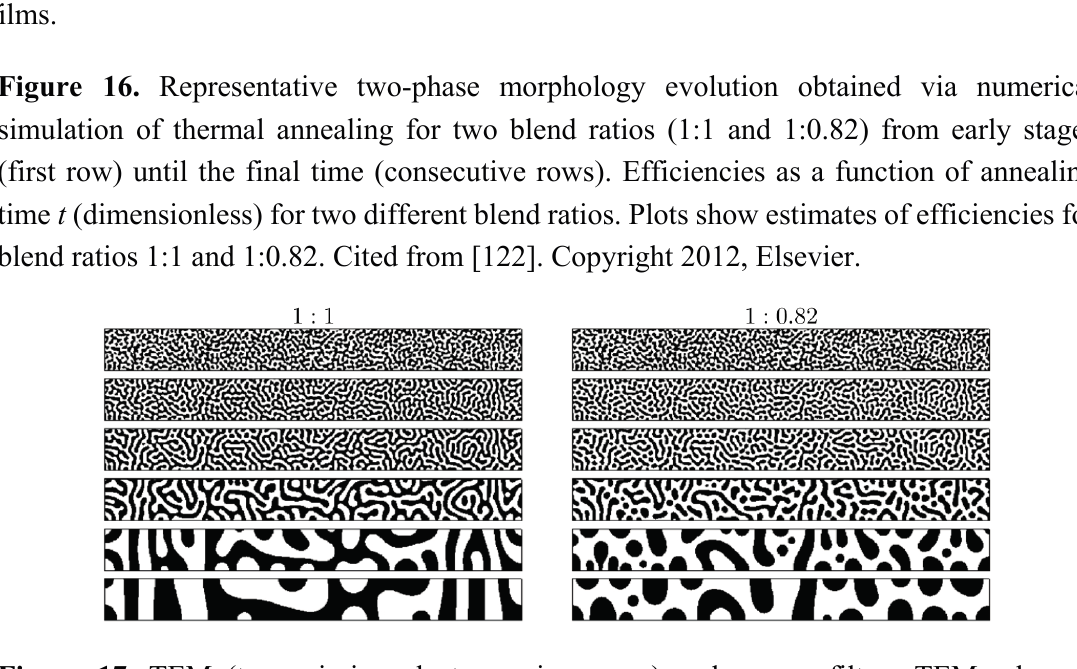
Figure 17. TEM (transmission electron microscope) and energy filtere TEM- element specific imaging (ESI) micrographs from a cross-section of the solar cell: ( a , b ) bright-field-TEM images of the pristine and the annealed device; ( c , d ) ESI images of the solar cell before and after annealing for 10 min at 130 °C. The color scale displays the varying sulfur concentrations throughout the photoactive layer. The cross-sections were prepared by microtome cutting, which induces a high mechanical stress in the layers and can cause layer delamination. Because of this delamination, the top electrode is missing in the image of the pristine solar cell cross-section; ( e , f ) The profile analysis along the white arrows (in Panels c and d ) revealed a more pronounced relative sulfur distribution for the annealed sample. Cited from [123]. Copyright 2013, America Chemical